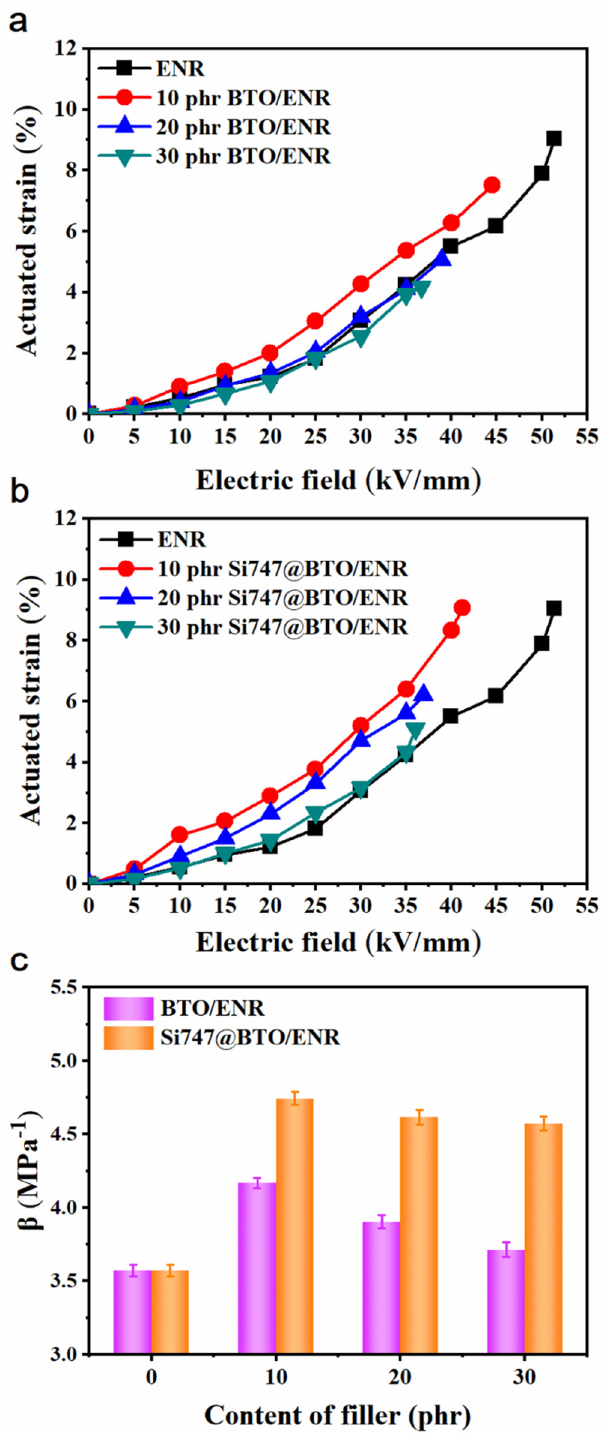
Figure 6. Actuated strains of ENR composites. ( a ) BTO/ENR, ( b ) Si747@BTO/ENR, and ( c ) β of ENR composites.